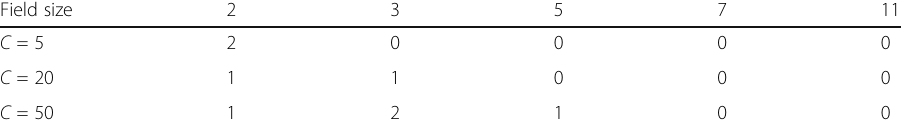
Table 1 Several examples about the decline of T . For example, the rank of T is 3 ( C − 2) when C = 5 and the field size is 2. In this case, the declined amount about the rank of T is 2. Field